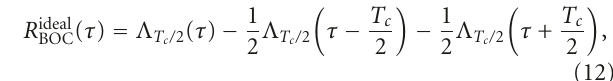
Figure 7: Envelope correlation function of traditional noncoher- ent integration and di ff erential correlation for a SinBOC(1,1)- modulated